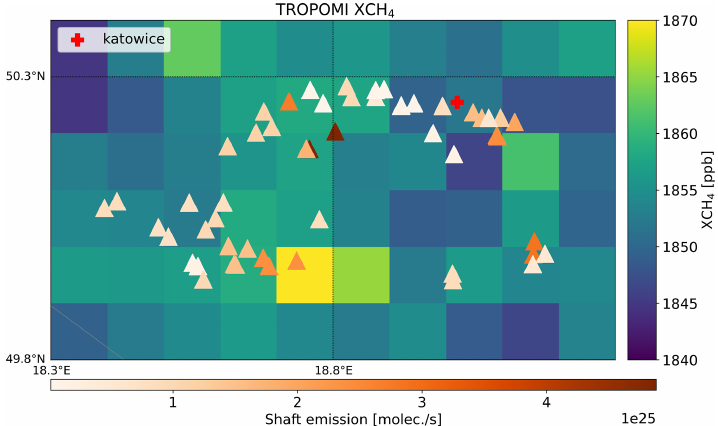
Figure A2. A zoomed figure of Fig.